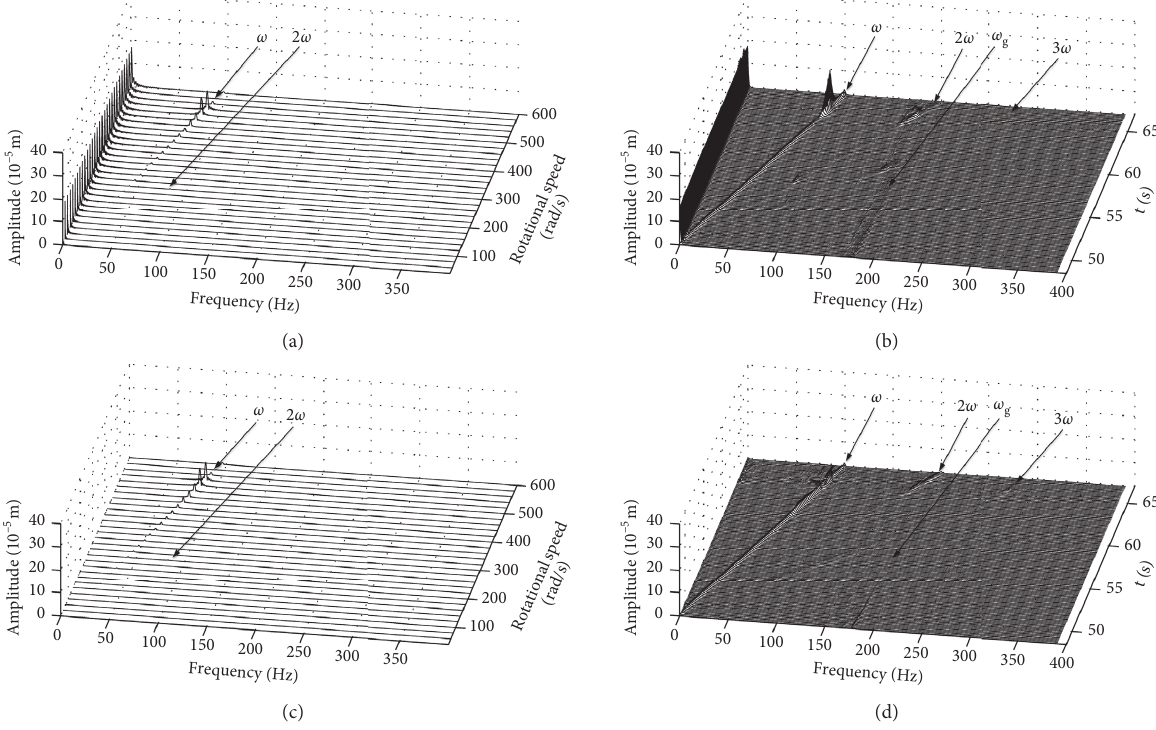
Figure 9: Waterfall spectra plots for the response of disk 3 during rolling. (a) Horizontal response, numerical simulation. (b) Horizontal response, experimental results. (c) Vertical response, numerical simulation. (d) Vertical response, experimental